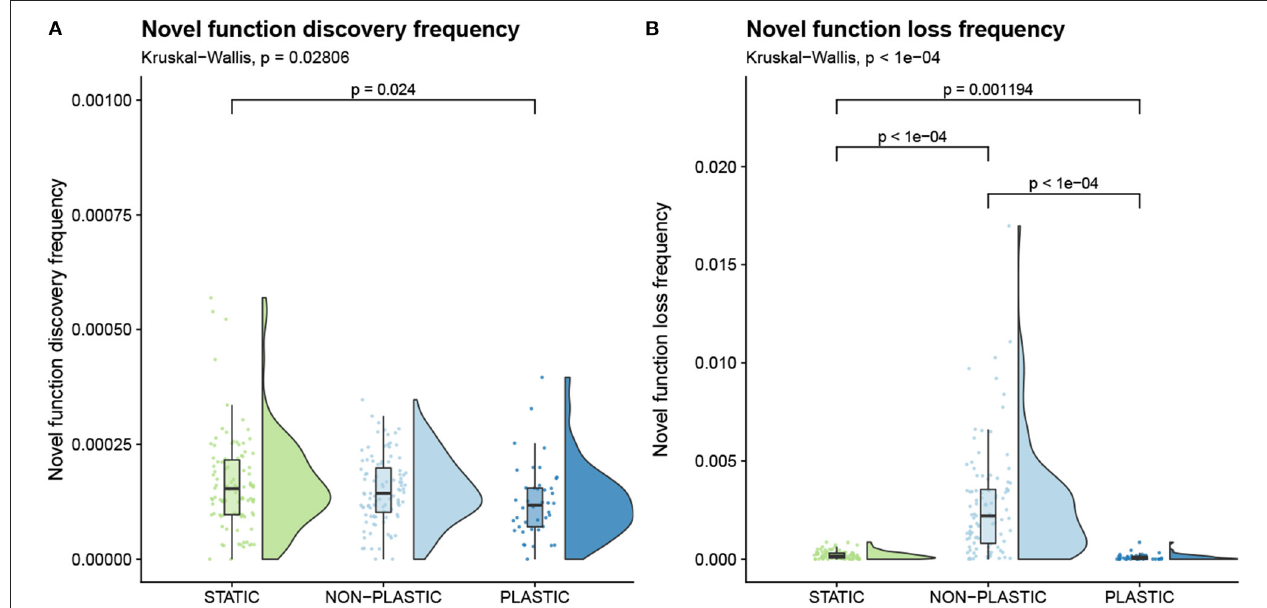
FIGURE 7 | Rate of novel function evolution. Raincloud plots of (A) novel function discovery frequency and (B) novel function loss frequency. Each plot is annotated with statistically significant comparisons (Bonferroni-corrected pairwise Wilcoxon rank-sum